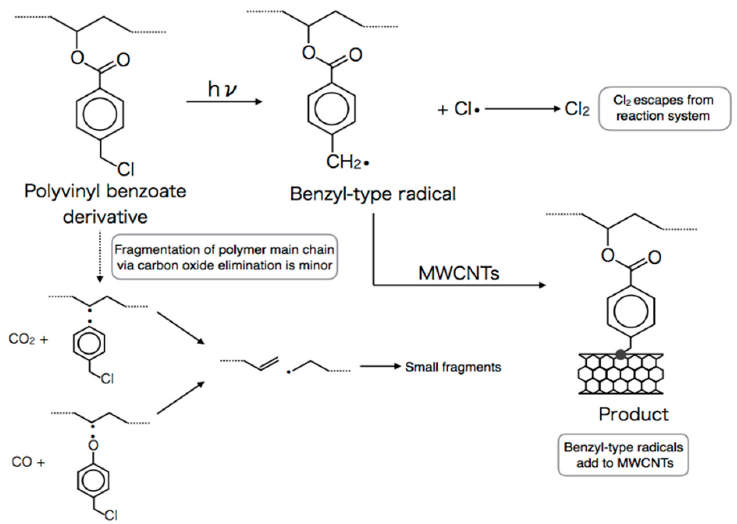
Figure 4. Schematic illustration of the chemical modification of MWCNT with radicals generated from polyvinyl 4-(chloromethyl)benzoate side chain.